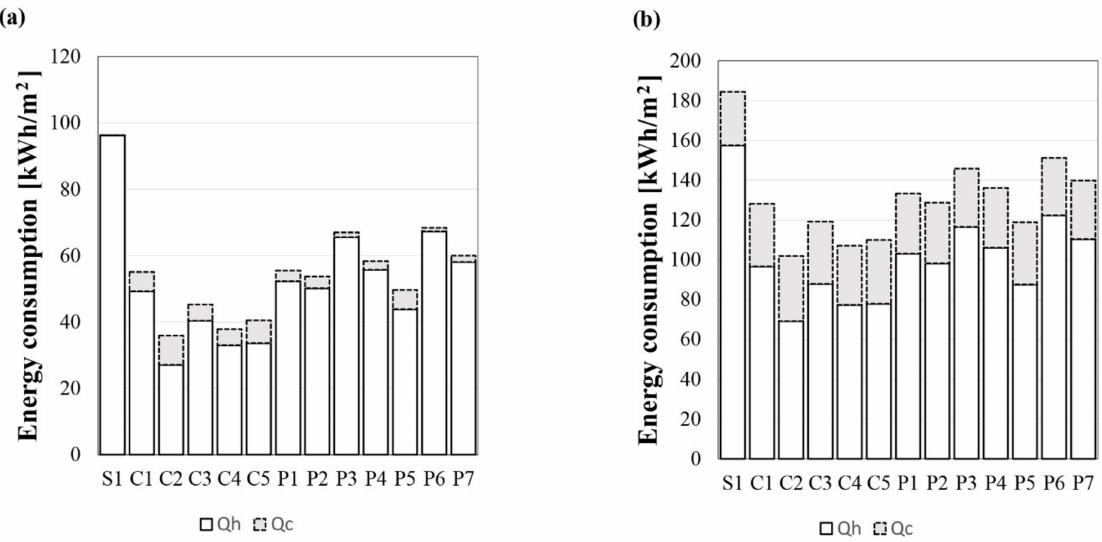
Figure 10. Annual thermal energy demand for heating (Qh) and cooling (Qc) in Monfero ( a ) and Turin ( b